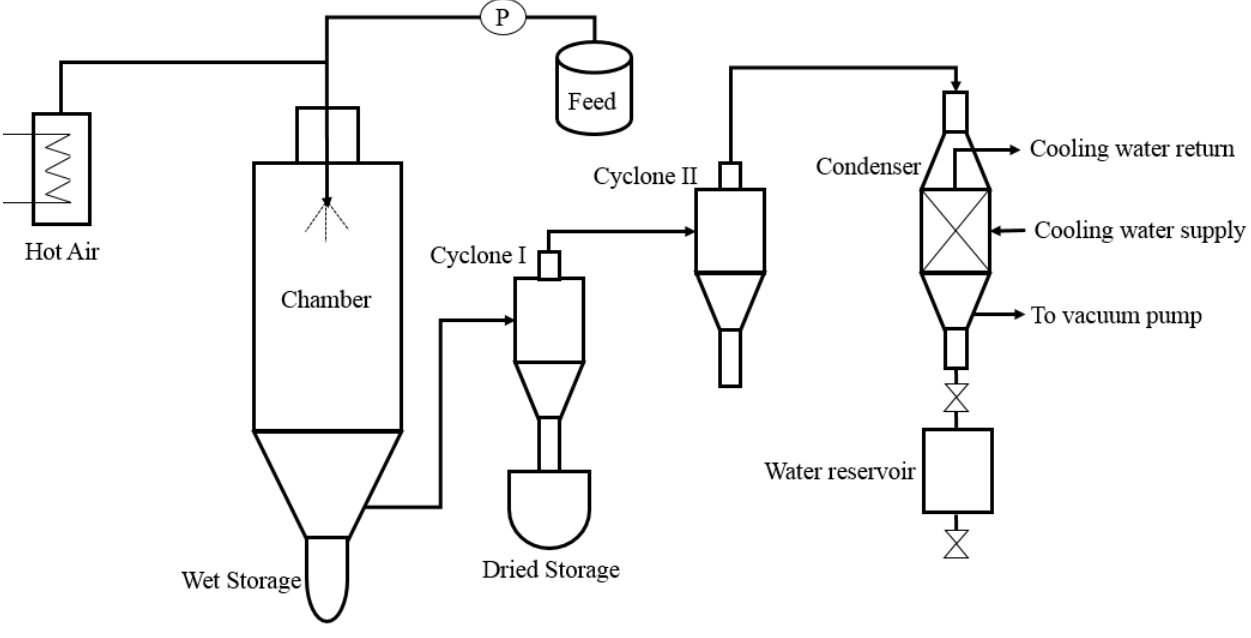
Figure 1. Schematic diagram of vacuum spray drying method. Curcumin (1,7-bis (4-hydroxy-3-methoxyphenyl)-1,6-hepta-dien-3,5-dione) is a nat- ural pigment polyphenol extracted from turmeric plant ( Curcuma longa ) [14]. Curcumin has several functions: antioxidant, antitumor, anticarcinogenic, and anti-inflammatory [15,16]. In clinical studies, curcumin is observed to have many benefits and is safe to use at high doses. However, its physical characteristics limited its use in oral pharmaceutical delivery due to very low solubility. A curcumin compound is susceptible to light, temper- ature, moisture, and oxygen. Curcumin is less stable at acidic pH levels and it decomposes rapidly at extreme pH levels [16,17].